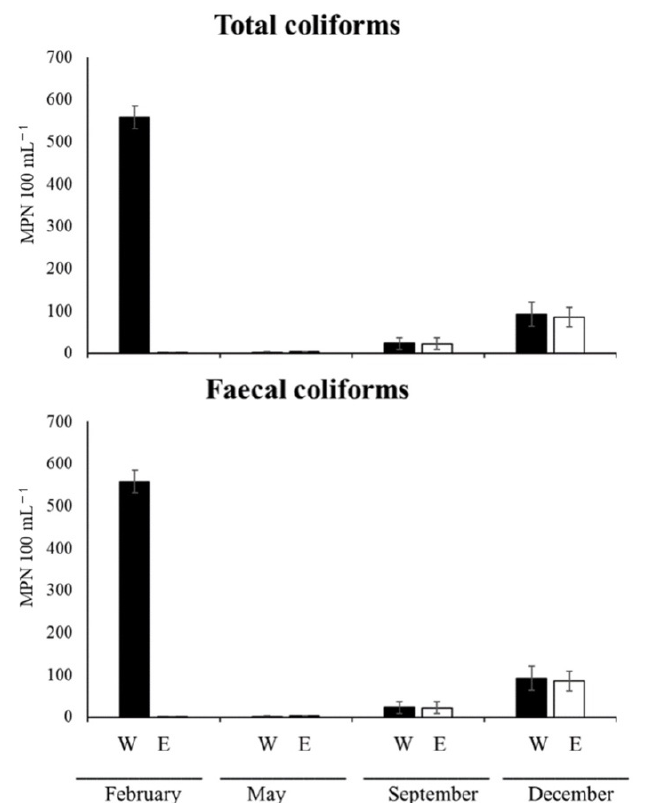
Figure 4. Density and size composition of Aurelia coerulea in W and E zones during the sampling times.